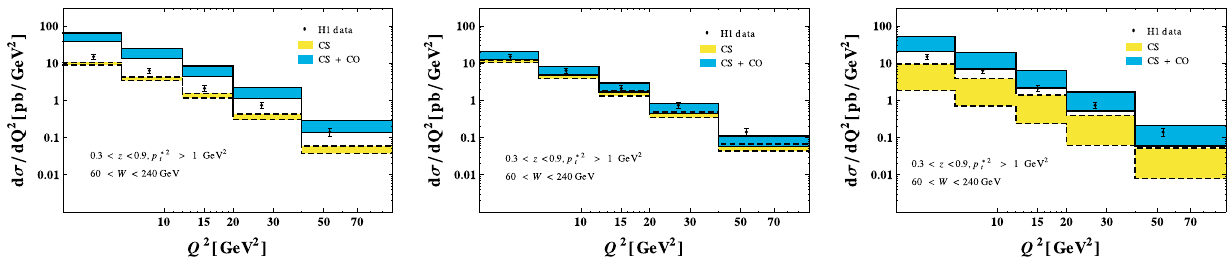
Fig. 8 The differential cross sections for the J /ψ production in DIS with respect to Q 2 . The experimental data are taken from Ref. [50]. The l.h.s., middle, and r.h.s. plots correspond to the LDMEs taken in Refs. [28,30,41],